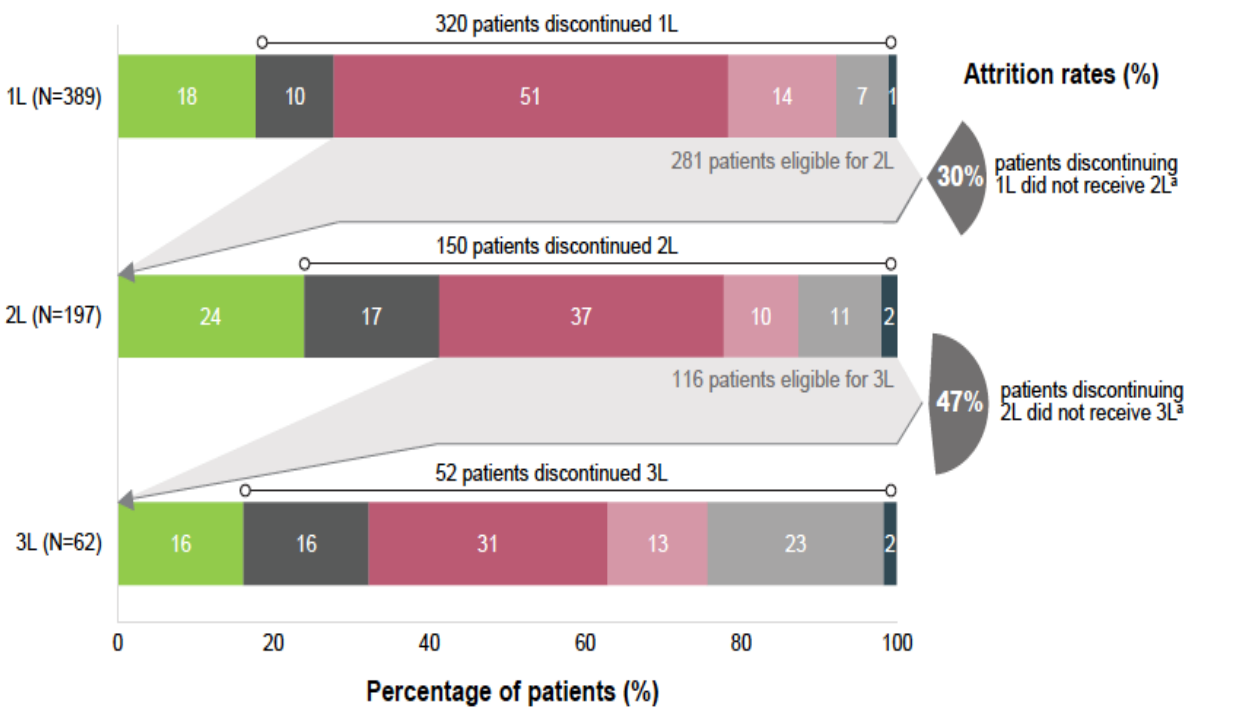
Figure 2. Reasons to discontinue first-, second- and third-line of therapy and attrition rates. Notes: Due to rounding, percentages may not always be 100%. a Deceased patients on each specific line have been excluded from the count. 1L, first line therapy; 2L, second line therapy, 3L, third line therapy; N, number of patients initiating each therapy line.